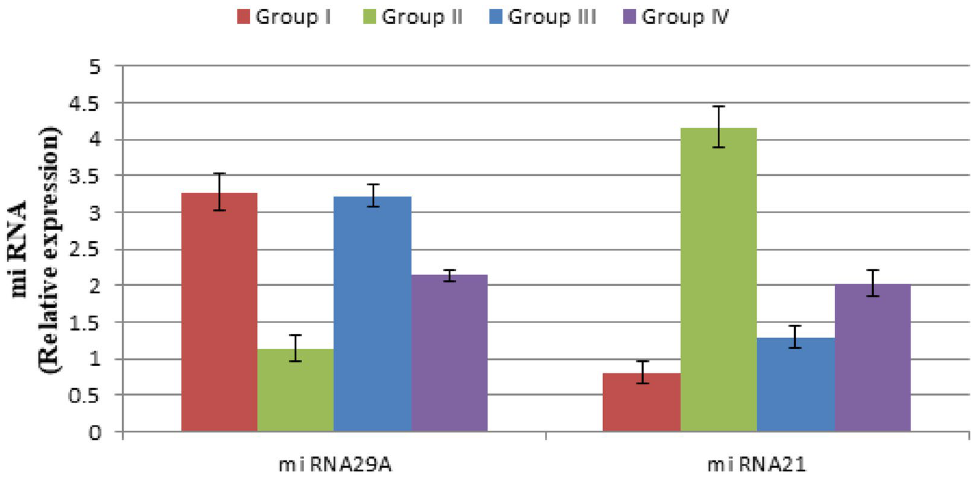
Figure 6. Variations in miRNA29A and miRNA21 expression in skin in DMBA-induced skin carcinogenesis animal model of different